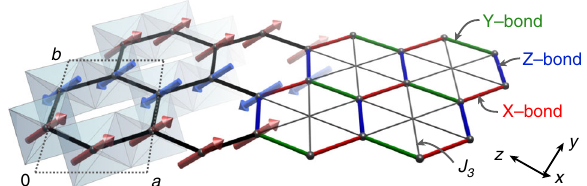
Fig. 1 From material to model. Within the honeycomb ab -layer of α -RuCl 3 are illustrated the RuCl 6 octahedra, magnetic zigzag ordering pattern, and de fi nition of the underlying magnetic interactions. Crystal axes are labeled with respect to the C 2/ m